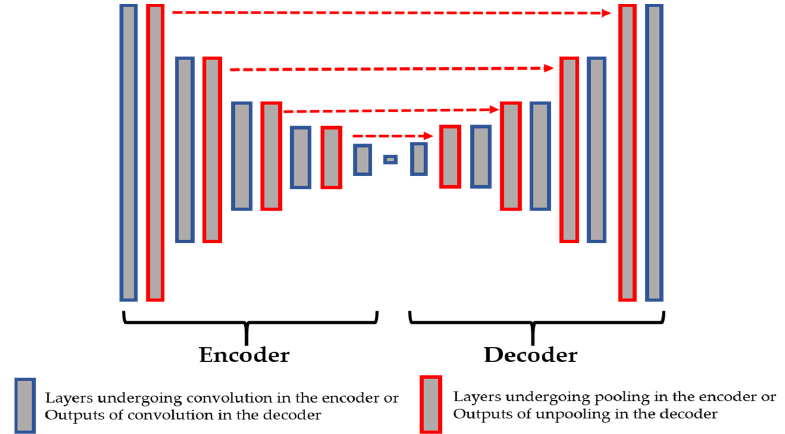
Figure 3. The connections between the pooling layers from the encoder and the unpooling layers from the decoder.